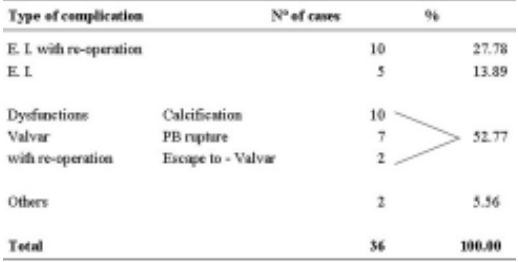
Fig. 4 - Survival curve free of endocarditis